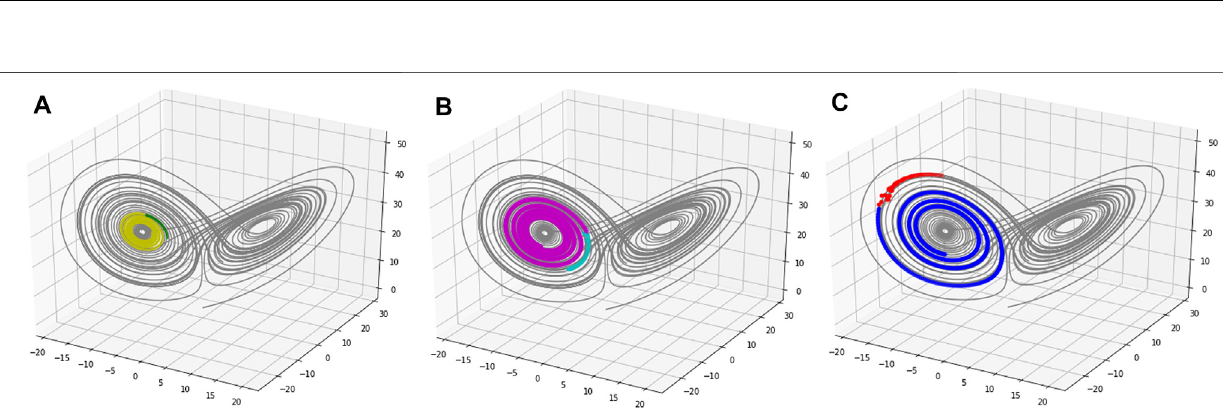
Frontiers in Genetics |